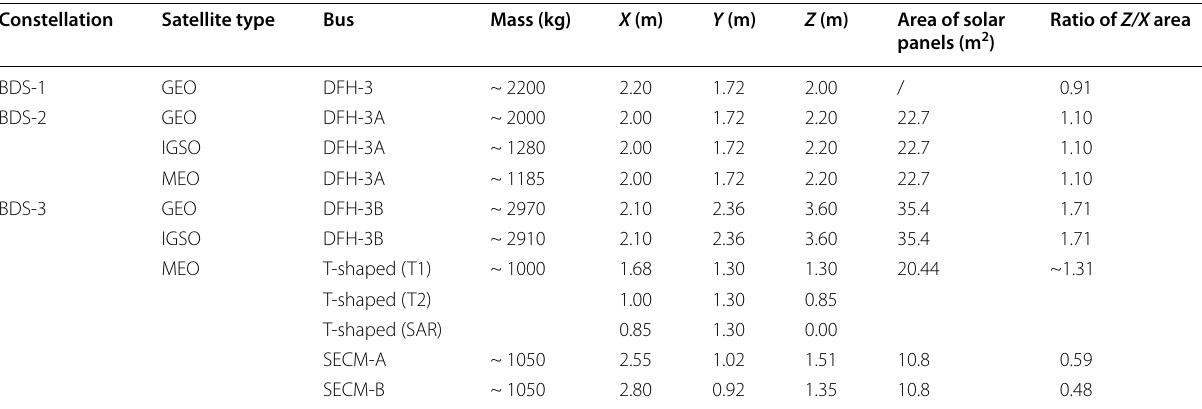
Table 2 Geometry dimensions of BDS satellite bus and mass Constellation Satellite